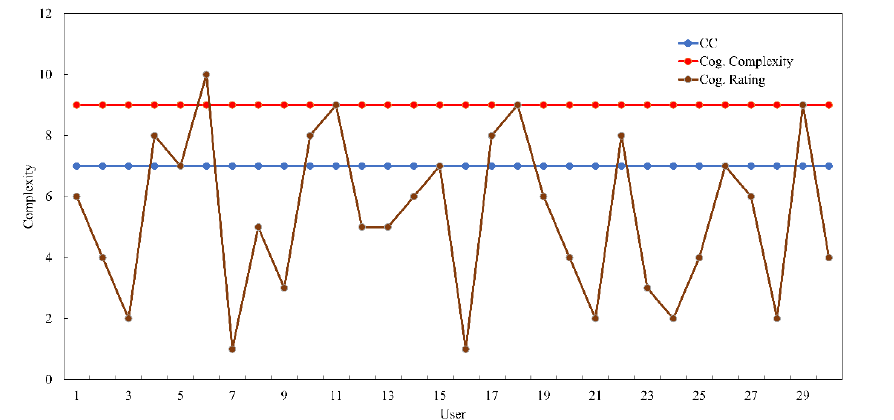
Fig. 2. Cognitive complexity rating with current complexity metrics for single project